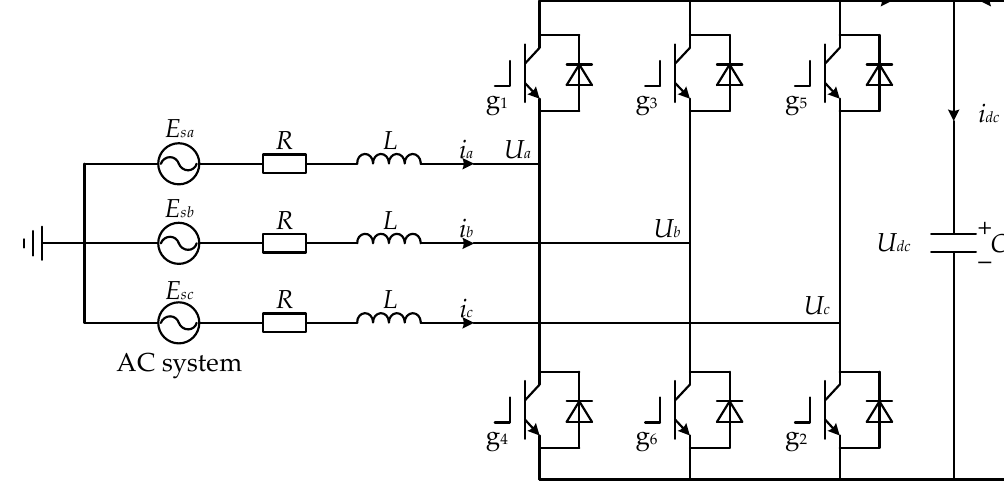
Figure 2. Structure diagram of the topology.